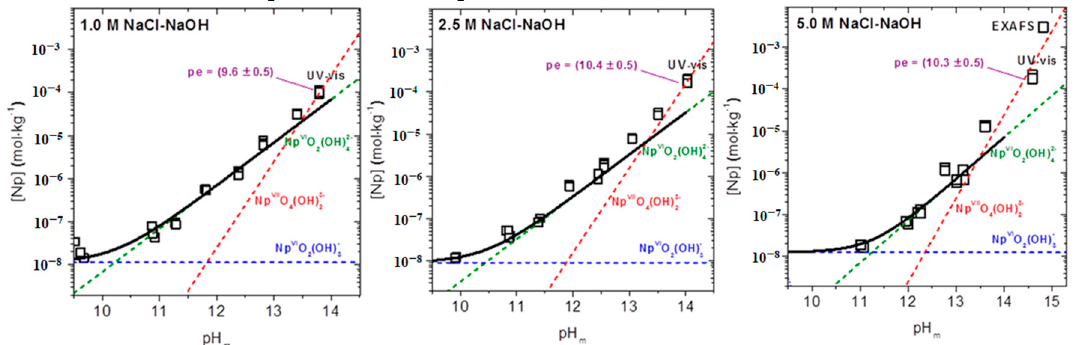
Figure 2. Experimental solubility data of Na 2 Np 2 O 7 (cr) in 1.0, 2.5 and 5.0 M NaCl–NaOH solutions, as reported in [42] and determined in this work. Solid lines correspond to the solubility of Na 2 Np 2 O 7 (cr) calculated with the thermodynamic and activity models reported in [42] for Np(VI). Blue and green dashed lines correspond to Np(VI) aqueous speciation underlying the solubility of Na 2 Np 2 O 7 (cr). The red dashed line indicates the contribution of the Np(VII) species NpO 4 (OH) 23 − to the solubility as proposed in this work. The figures indicate also those samples for which UV-vis [42] and XAFS (present work) spectra of the supernatant solution were collected.